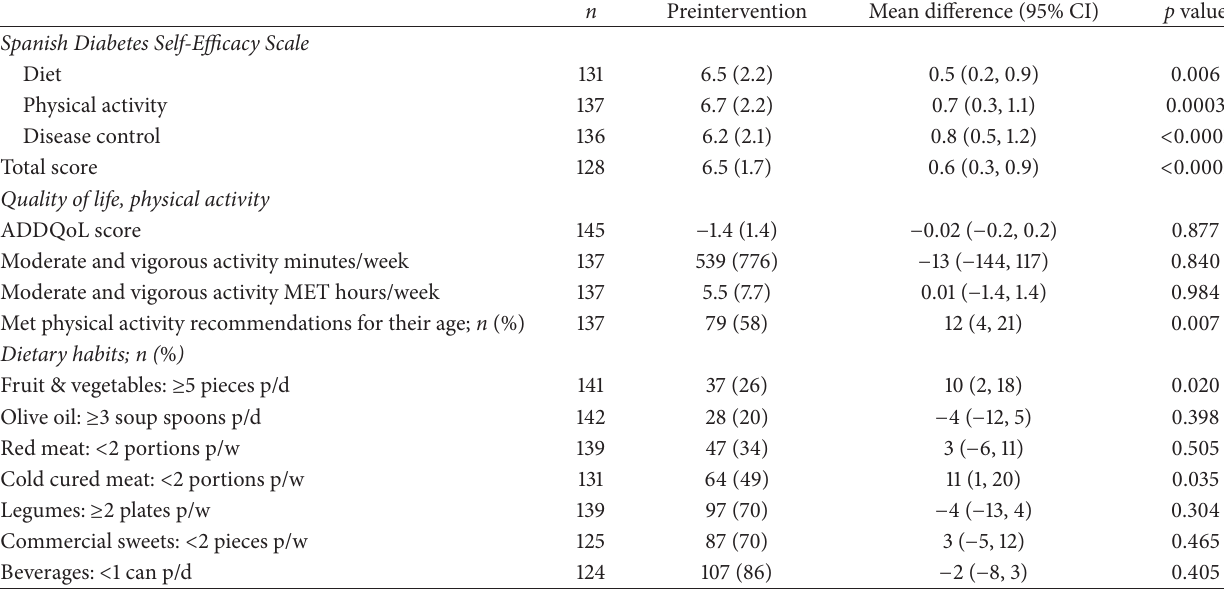
Table 3: Variables related to self-efficacy, quality of life, diet, and physical exercise at baseline and 6 months after the intervention.